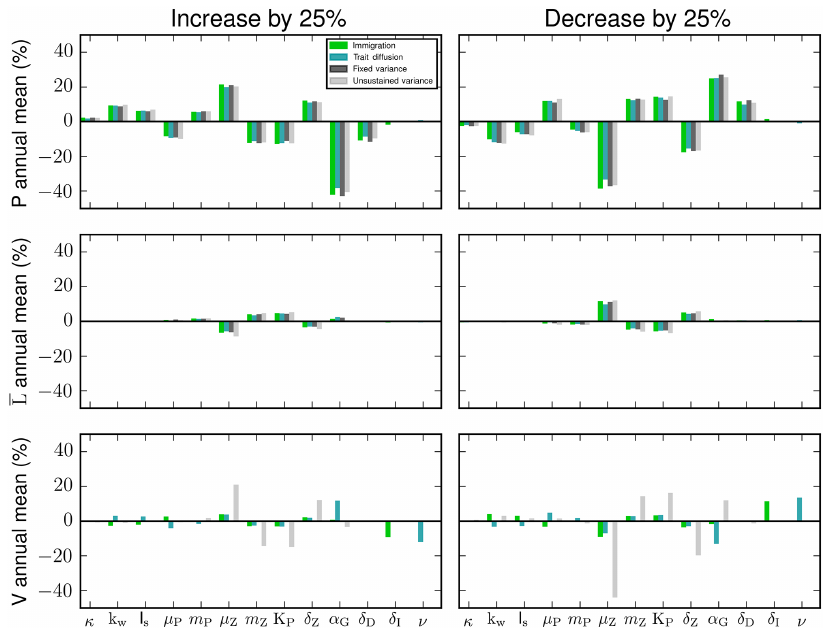
Figure 7. Sensitivity of four variance treatments to an increase and a decrease by 25% in the default parameter values. The values and definitions of all parameters are given in Table